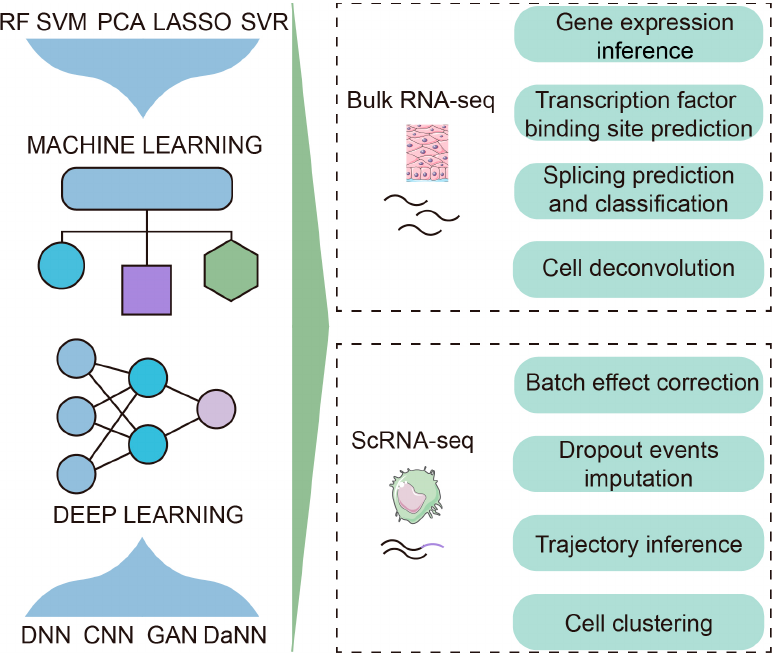
Figure 1. The applications of AI techniques in transcriptomics. AI algorithms have extensively promoted the development of transcriptomics. Numerous cutting-edge bioinformatics frameworks have been established to perform specific tasks, such as gene expression inference, transcription factor binding site prediction, splicing prediction, cell deconvolution, batch effect removal, missing imputation, trajectory inference, clustering, and more. RF, random forest; SVM, support vector machine; PCA, principal component analysis; LASSO, least absolute shrinkage and selection operator; SVR, support vector regression; CNN, convolutional neural network; DNN, deep neural network; GAN, generative adversarial network; DaNN, domain-adversarial training of neural networks.